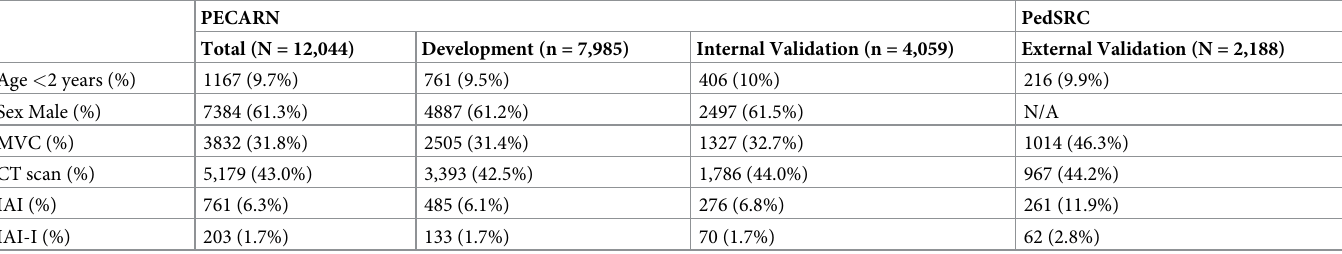
Table 1. Patient demographics and outcomes of the PECARN dataset split into development and validation (80:20), and the PedSRC external validation dataset.